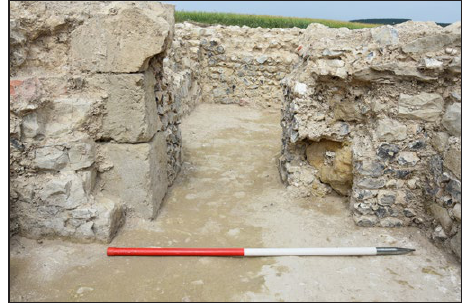
Figure 6: Detail of the construction show- ing dressed Caen stone, Upper Greensand wall-fill, and dressed flint internal facings. (Scale 0.5 m divisions). Photo: